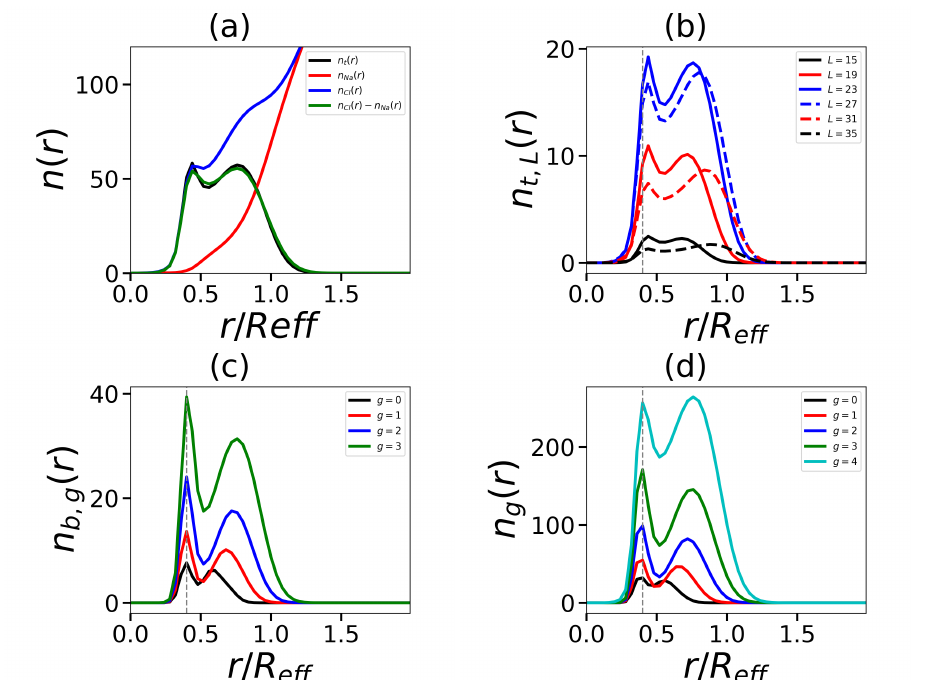
Figure 12. The radial distribution of ( a ) the terminal charged groups of dendrons, co-ions, and counterions, ( b ) the terminal charged groups with different contour lengths, ( c ) the branch points from different subgenerations, and ( d ) the dendron segments from different subgenerations. All cases correspond to the same number of tails t = 2, tail length N t = 60, and generation number G = 4. The vertically dotted gray lines on the graphs ( b – d ) indicate the location of the core size R core